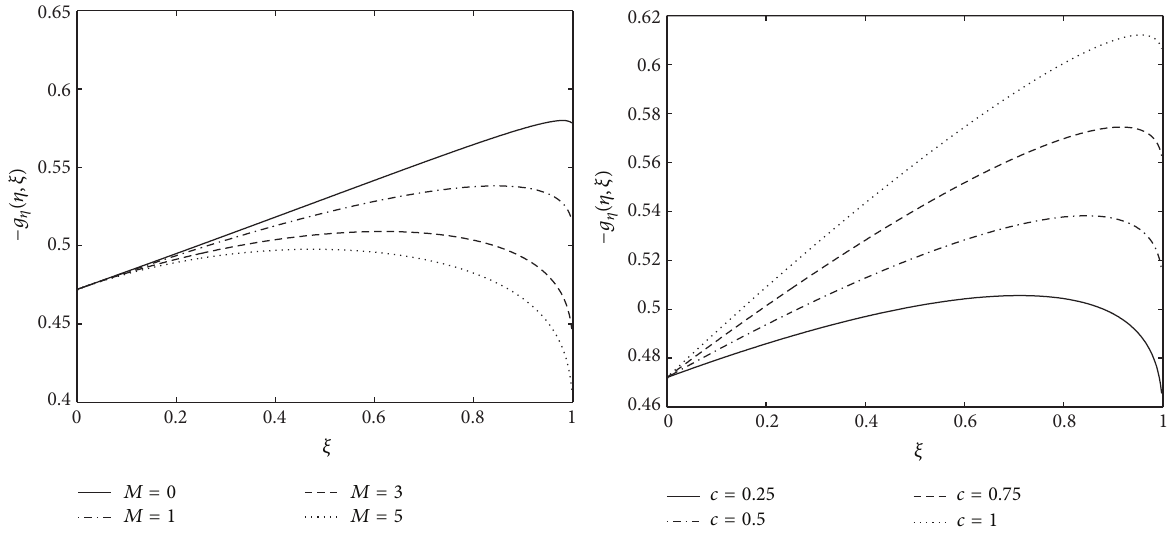
Figure 4: CFDRM solution of −𝑔 󸀠 (0, 𝜉) for different values of 𝑀 and 𝑐 , respectively, when Pr = 0.7 .